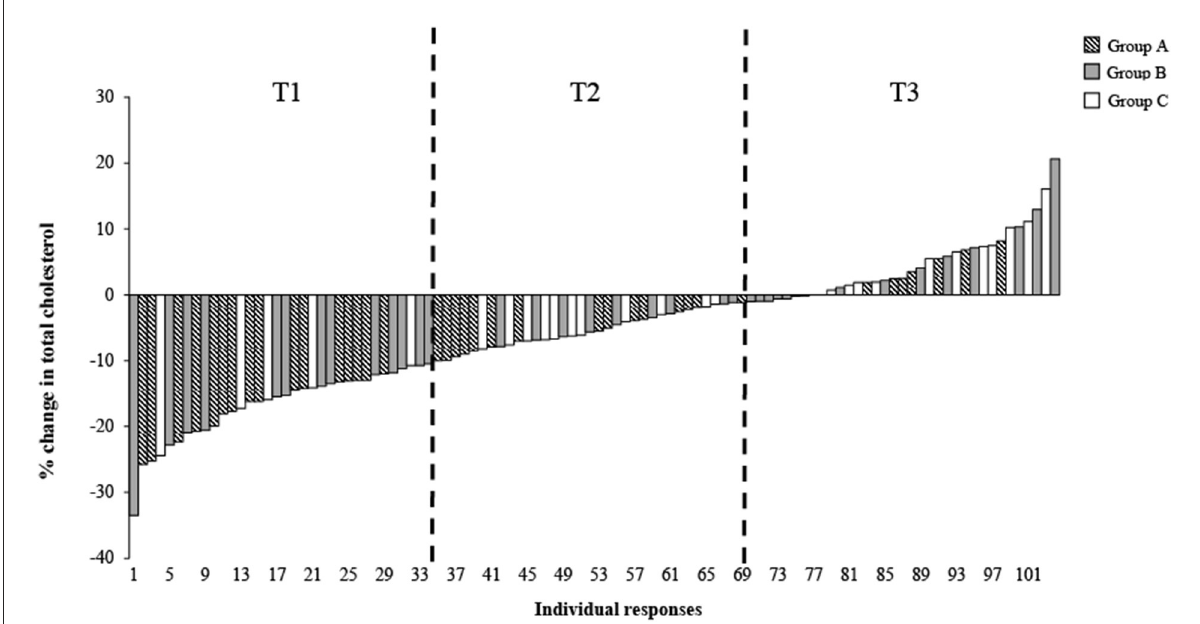
FIGURE1 Distribution of individual responses for total cholesterol (%) following 6 weeks of a dairy fat intervention across the total population and the three diet intervention groups. Each bar represents an individual’s % total cholesterol change 1 , delta; T1, Tertile 1; T2, Tertile 2; T3, Tertile 3.